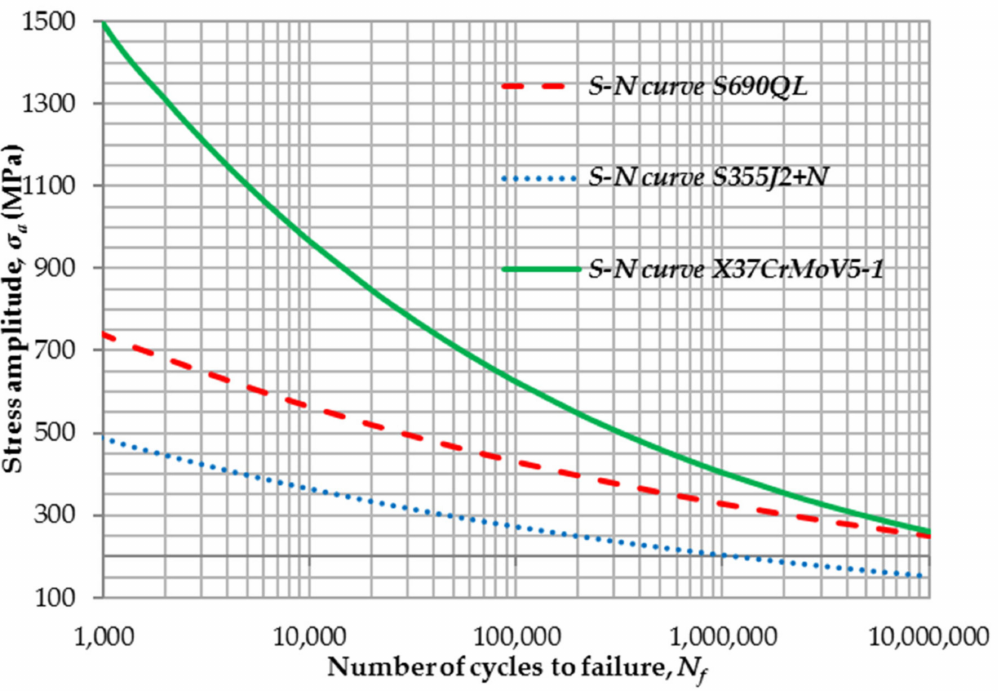
Figure 9. Combined diagram of semi-log S – N curves for S355J2+N, S690QL, and X37CrMoV5-1 steel